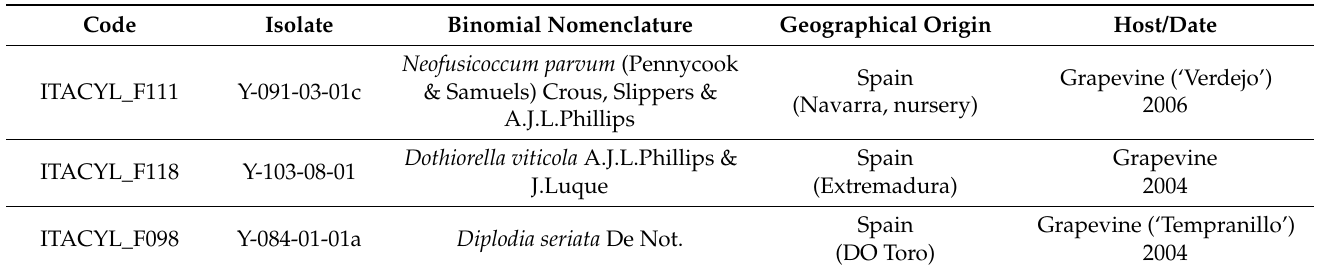
Table 1. Fungal isolates used in the